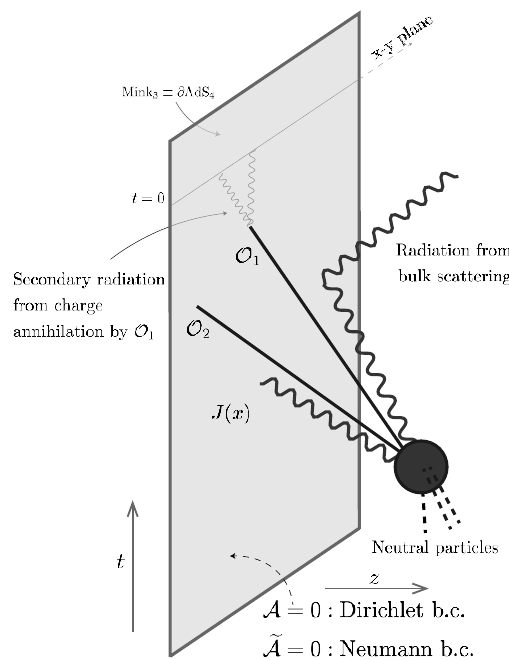
Figure 5. A @ AdS 4 correlator for radiation and charged matter created by a distant bulk scattering, initiated from an electromagnetically neutral state. We focus on a ’t Hooft line at t = 0 in